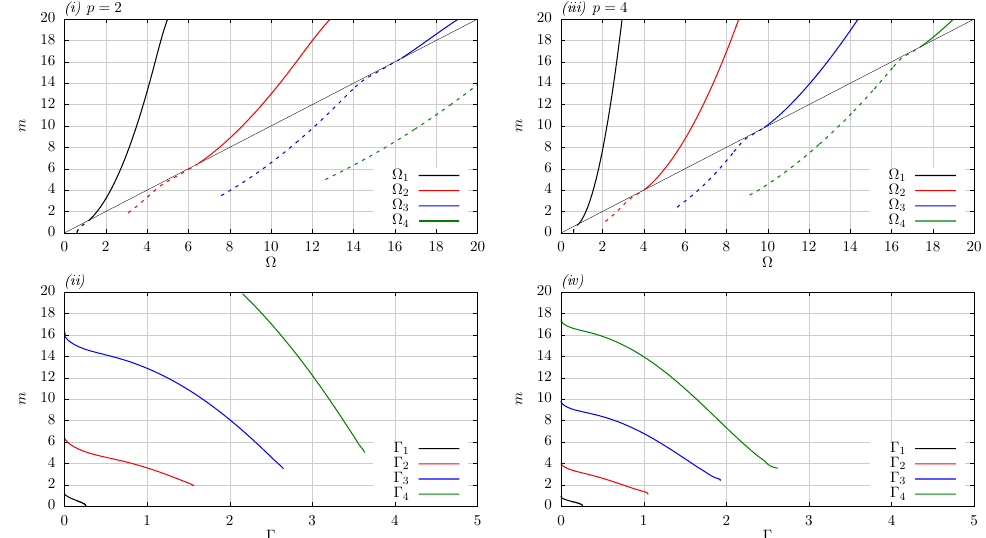
Figure 6 . The frequency (cid:10) and width (cid:0) of the lowest resonance mode as a function of the pion mass for the Lin-Piette potentials p = 2 and p = 4.